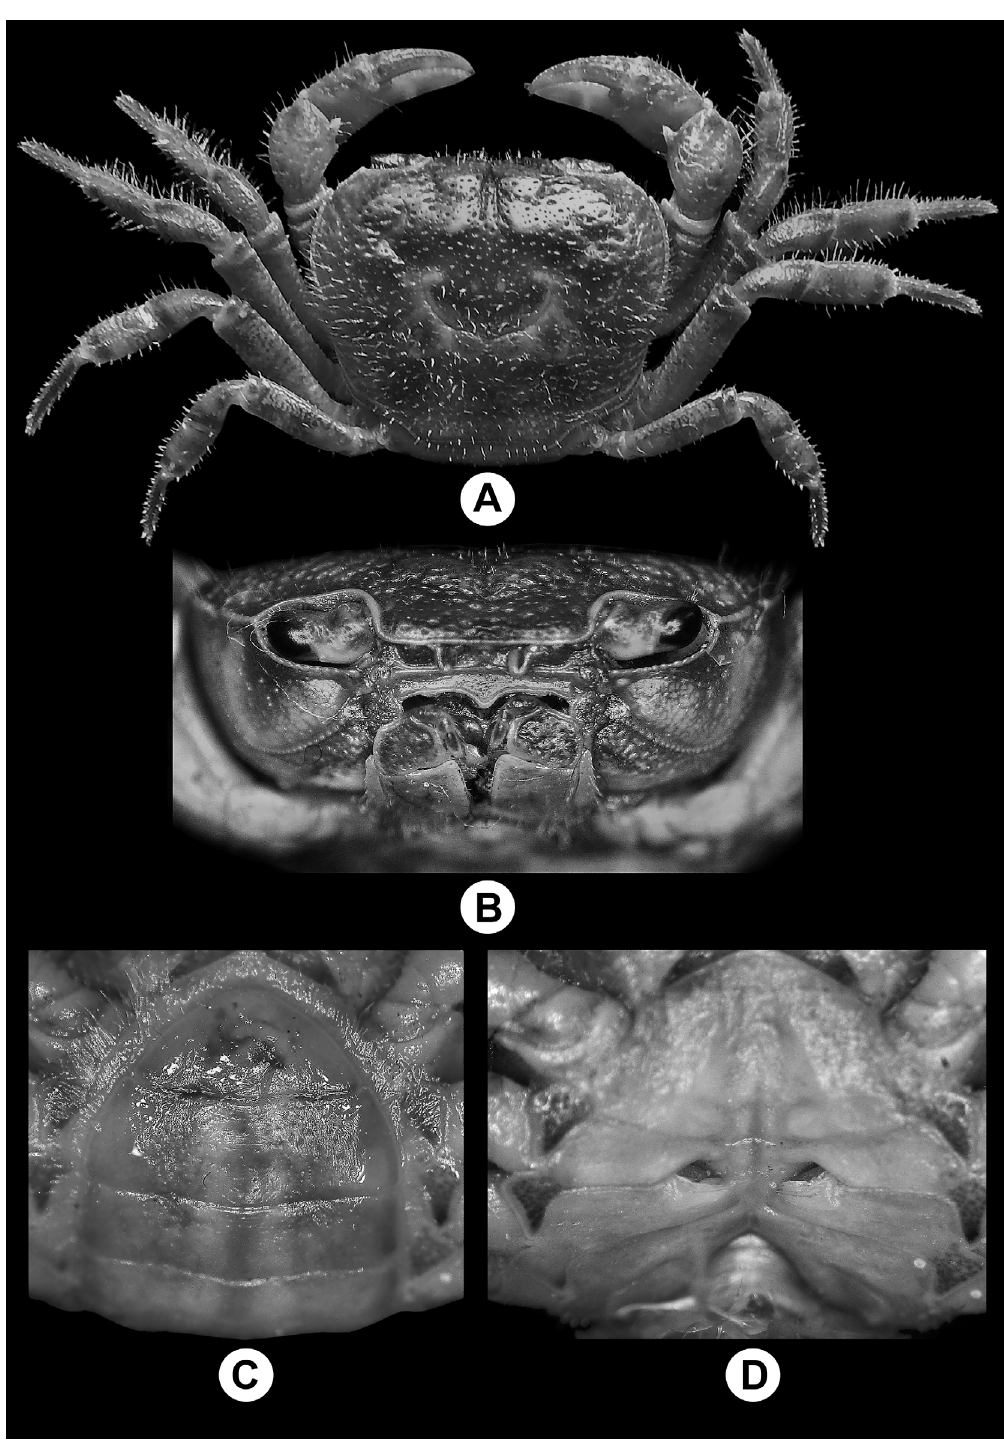
Figure 8. Abormon capillosum sp. nov., paratype female (14.5 × 11.8 mm) (ZSIK C.8612/2). A , overall dorsal view; B , frontal view of cephalothorax; C , pleonal somites 4–6 and telson; D , thoracic sternites showing